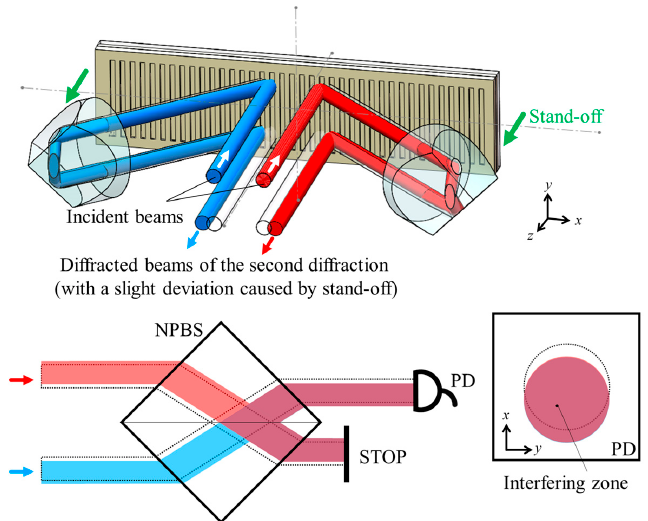
Figure 3. Geometrical analysis of the stand-off error and its influence on the measurement beam caused by spots